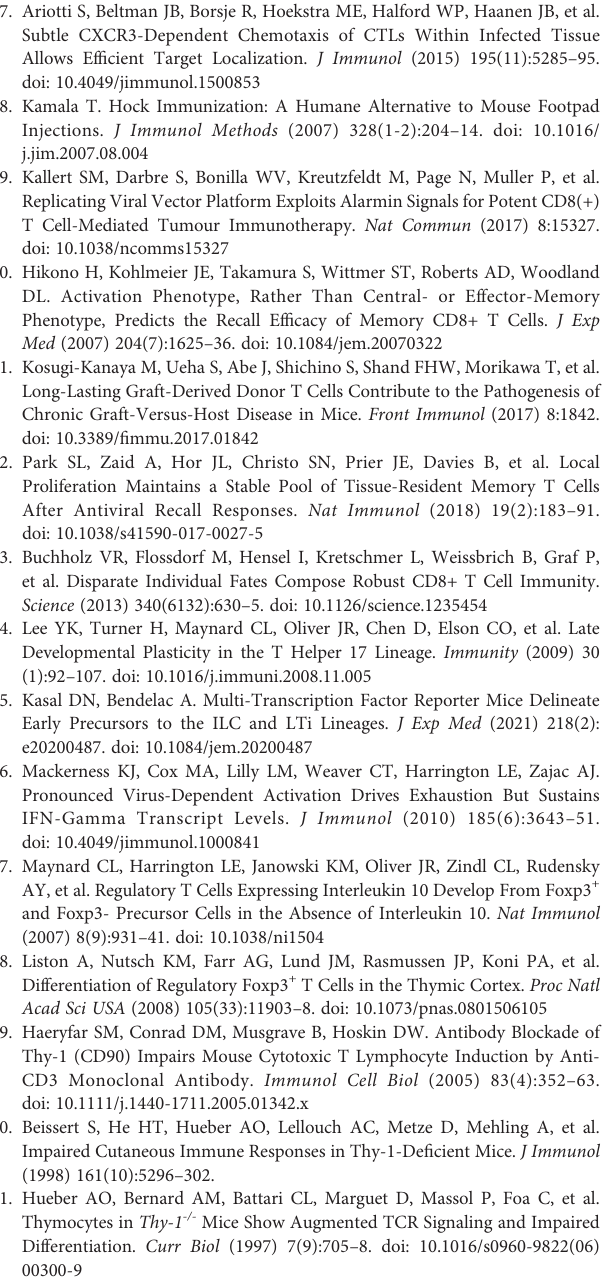
Supplementary Figure 7 | CD127 and KLRG1 expression on OT-I cells in popLN and PBL after LCMV-OVA challenge. (A) Pie charts showing mean frequencies offour subsets identi fi ed by the expression pattern of CD127 and KLRG1 (as shown in ) in popLN and PBL. (B) Scatter plots of the data shown in (A) and . ** p < 0.01,